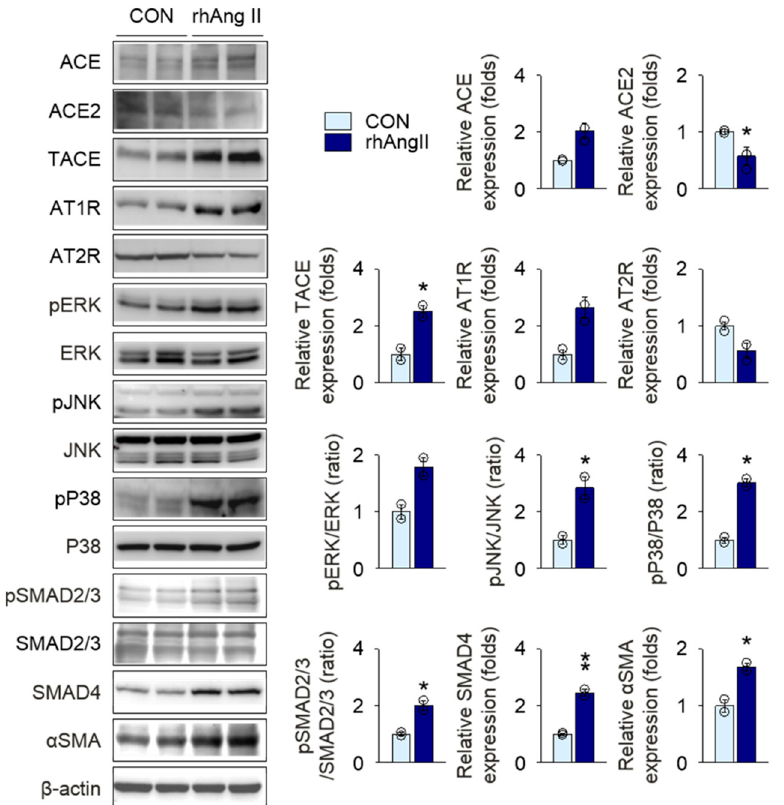
Figure 6. Stimulation with Ang II activates downstreams of TGF β in HK-2 cells. Comparison of protein expression level for RAS components, MAPKs, and downstreams of TGF β in HK-2 after stimulation with vehicles or recombinant human Ang II (rhAng II) ( n = 3 − 4/group). Data are representative more than three independent experiments. * P < 0.05, ** P < 0.01 versus vehicle group by Student’s T-test.